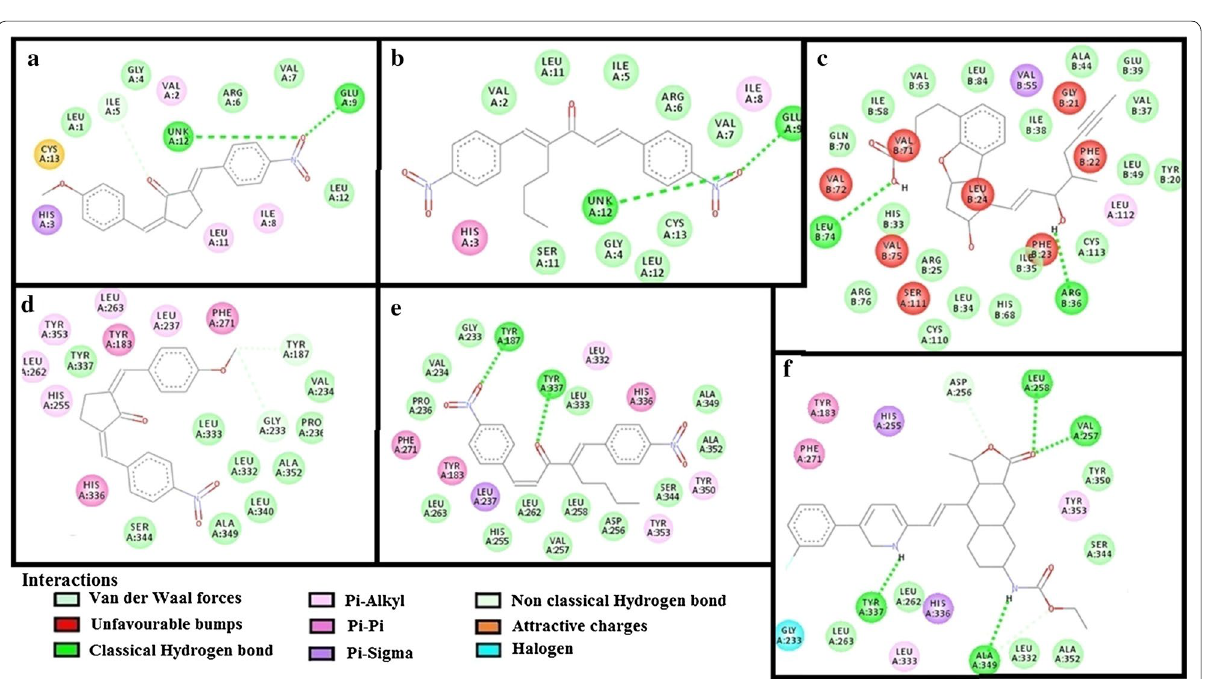
Fig. 9 a – c Represents interactions of ligands: (2 E ,5 E )‑2‑(4‑methoxybenzylidene)‑5‑(4‑nitrobenzylidene)cyclopentanone (AK‑1a), (1 E ,4 E )‑4‑(4‑nit robenzylidene)‑1‑(4‑nitrophenyl) oct‑1‑en‑3‑one (AK‑2a) and beraprost with target: prostacyclin receptor I 2 (PG‑I 2 ) respectively. d – f Represents interactions of AK‑1a, AK‑2a and vorapaxar with target: proteinase‑activated receptor 1 (PAR‑1) respectively, drawn through Biovia Discovery Studio Visualizer client